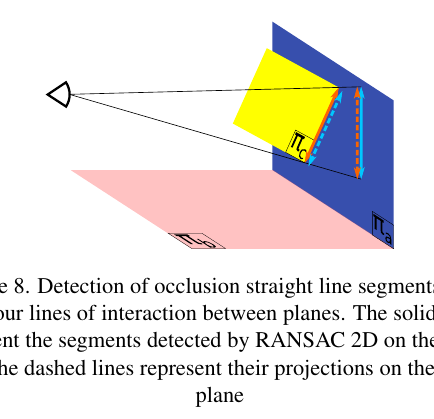
Figure 6. Contour lines and modeled straight line segments. (a) Contour lines of π c interacting with π a and π b . (b) Straight line segments to model contour. The green segments correspond to occlusions. The red segments correspond to intersections between the planes of the set Π (cid:96) . We call this new set of poten- tial pixels Q (cid:96) ∗ . Figure 7 gives an example of the result obtained for the contour of the planar primitive studied (see Figure 5). If the number of pixels included in (cid:8) Q (cid:96) ∩ Q (cid:96) ∗ (cid:9) is sufficient, the line must contain an intersection, otherwise, we deduce that it is a set of occlusion segments. In the example of Figure 7, most of the contour lines have pixels in common with their theoret- ical intersection lines and are therefore labeled as intersections, except the yellow line which results only from an occlusion.